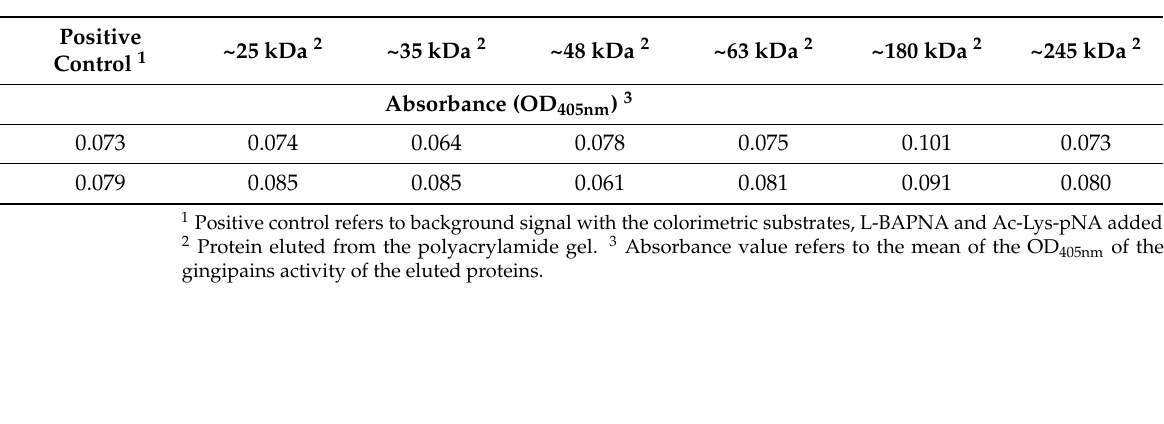
Figure 2. Native-PAGE of crude protein samples. The gingipains samples were solubilized in non- reducing solubilizing sample buffer and electrophoresed at 110 V for 90 min. Lane 1 was BLUeye pre-stained protein standards while Lane 2 and 3 were the crude protein samples. Table 1. Gingipain activity assay for eluted